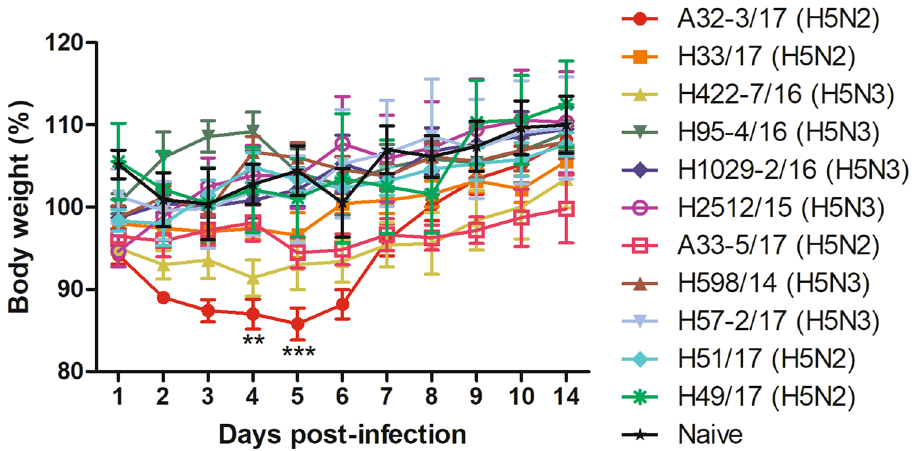
Figure 3. Pathogenicity of representative strains of H5 LPAIVs in mice, indicated by changes in body weight. BALB/c mice ( n = 5 per group) were challenged with 10 6 50% egg-infective doses per animal of each virus. Changes in body weight were observed for 14 days. No mortality occurred. Data points indicate means, and error bars indicate SEM. Data were analyzed by two-way ANOVA with Bonferroni’s post-test. Asterisks indicate statistical significance of the difference in body weight between naïve mice and mice infected with A32-3/17 (H5N2) virus (** p < 0.01; *** p < 0.001).